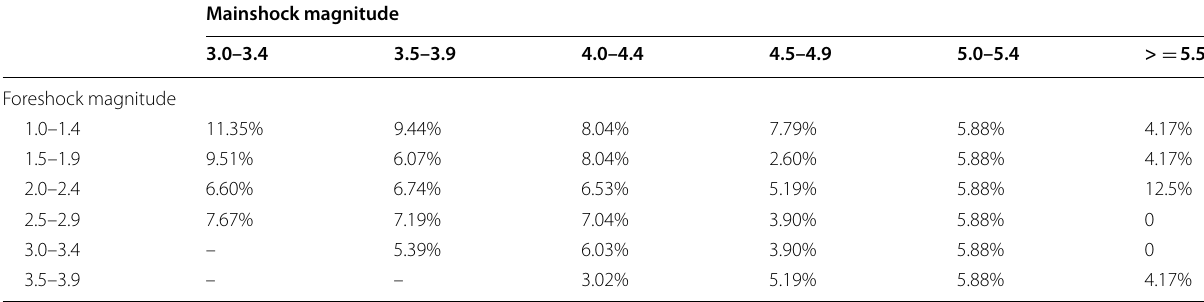
Table 2 Mainshock occurrence rate for different magnitudes of mainshocks as a function of foreshock magnitude